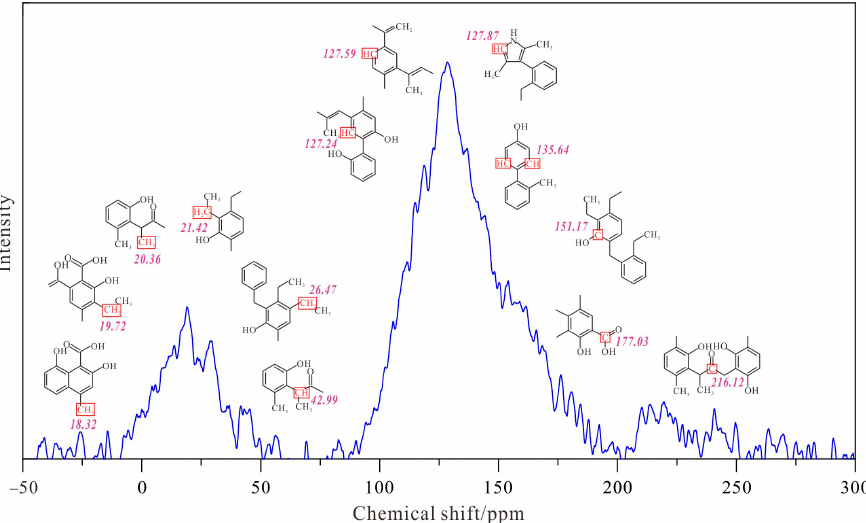
Figure 2. The 13 C nuclear magnetic resonance profile of the FK–3 coal with chemical shift assign- ments. 3.2.2. FTIR Spectra Analysis.